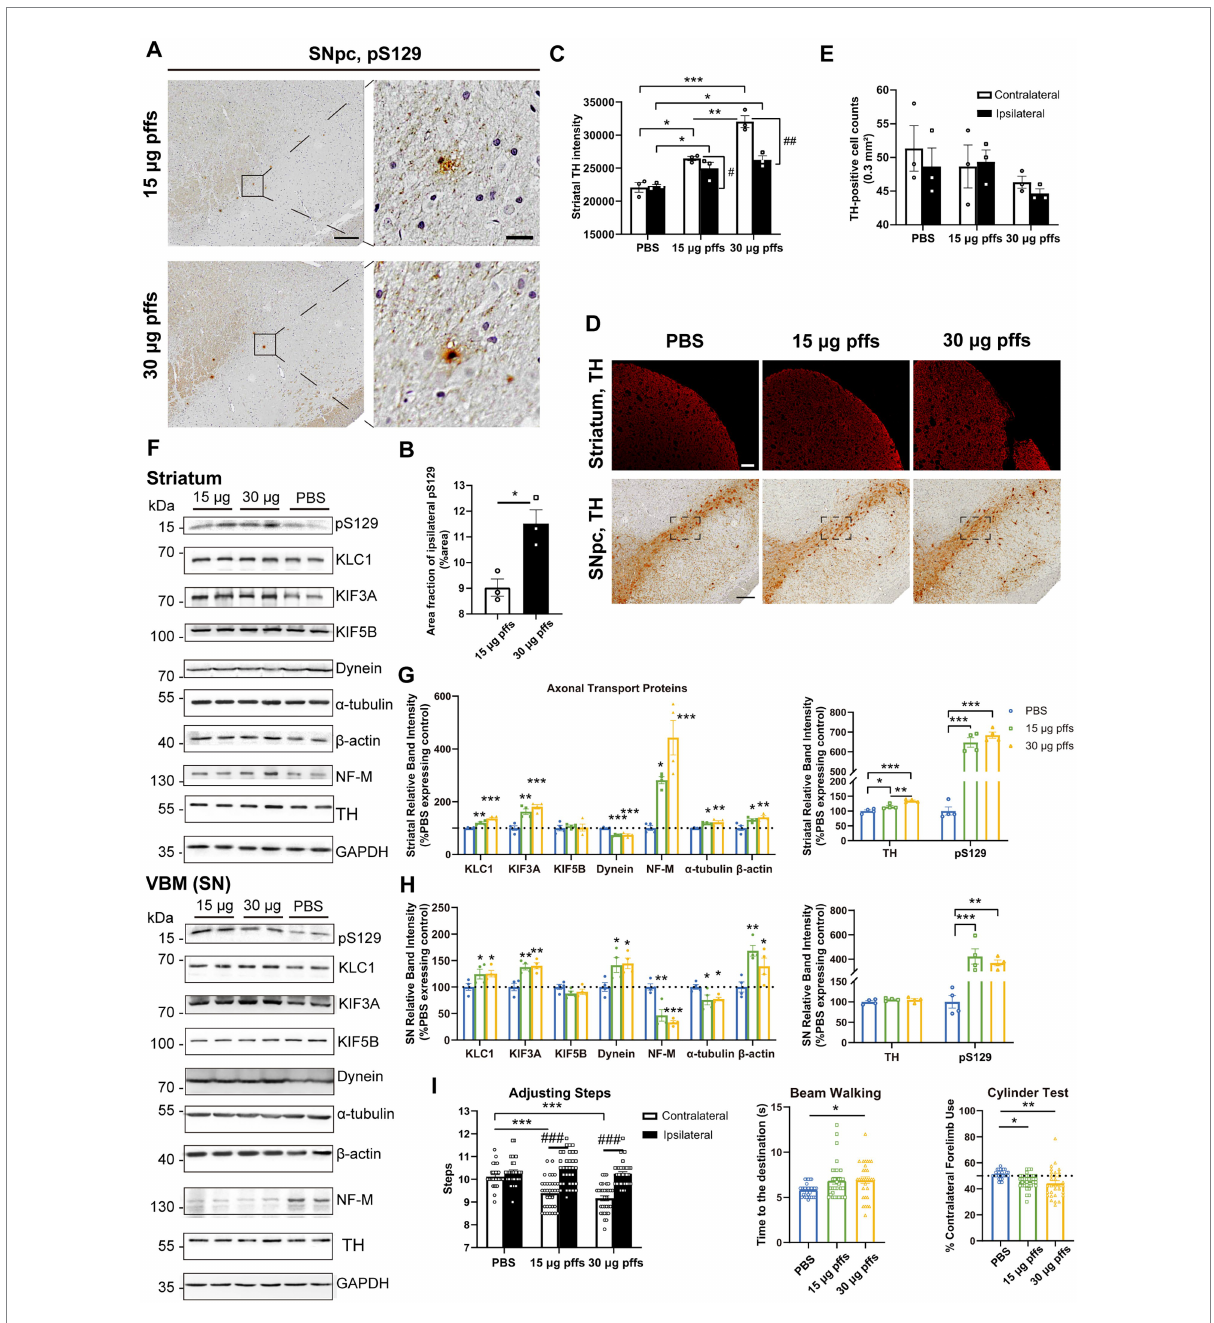
FIGURE 4 Evaluation of the nigrostriatal pathway at 1 month post injection. (A) α -Syn pathology was detected in the SNpc. Scale bar = 200 μ m (left) and 20 μ m (right). (B) The area fractions of the ipsilateral α -Syn pS129 in the SNpc of each group were quantified by ImageJ ( n = 3; * p < 0.05). (C) Fluorescent densitometry of striatal TH ( n = 3; * p < 0.05, ** p < 0.01, *** p < 0.001; # p < 0.05, ## p < 0.01). (D) TH-positive cells in the SNpc and striatum. Scale bar = 200 μ m. (E) TH-positive cells in the SNpc were quantified by counting. The boxes represent the SNpc region (area = 0.3 mm 2 ) where positive neurons were counted ( n = 3). (F) Representative western blot of nigrostriatal changes. GAPDH served as the internal control.